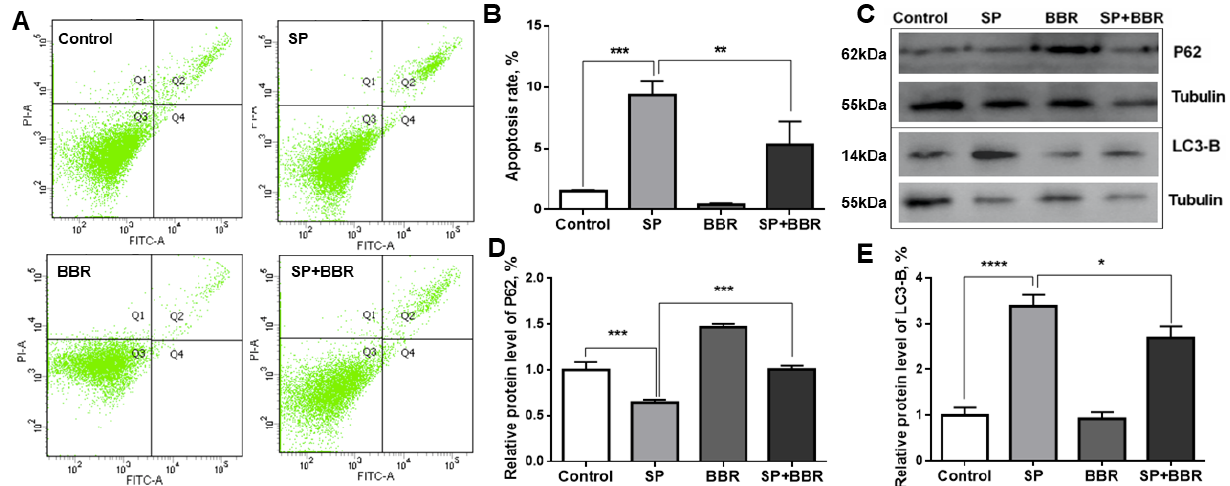
Figure 2. Berberine on sodium palmitate-induced hepatocyte apoptosis and autophagy. ( A ) is flow cytometry to detect ZFL apoptosis, each group has a cell count of 10,000. ( B ) is apoptosis and apoptosis rate of ZFL. ( C ) is WB diagram of P62 protein and LC3-B protein. ( D ) is relative expression level of P62 protein. ( E ) is relative expression level of LC3-B protein. Dates were presented as mean ± SEM ( n = 3). * p < 0.05, ** p < 0.01, and *** p < 0.001, **** p < 0.0001.